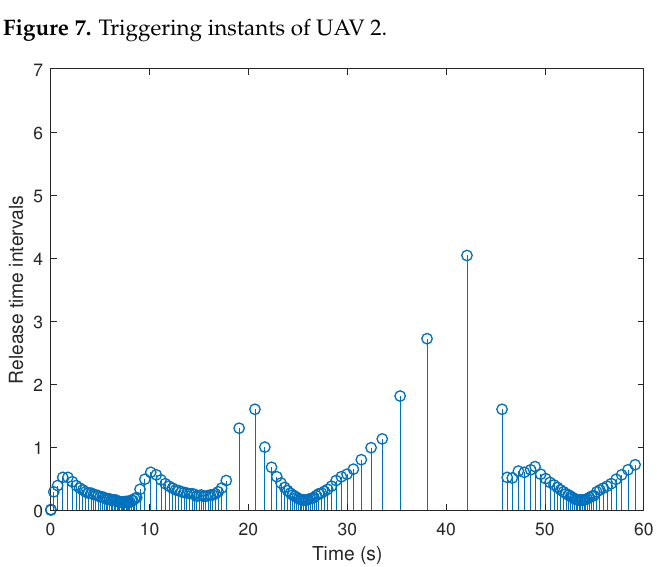
Figure 7. Triggering instants of UAV 2.